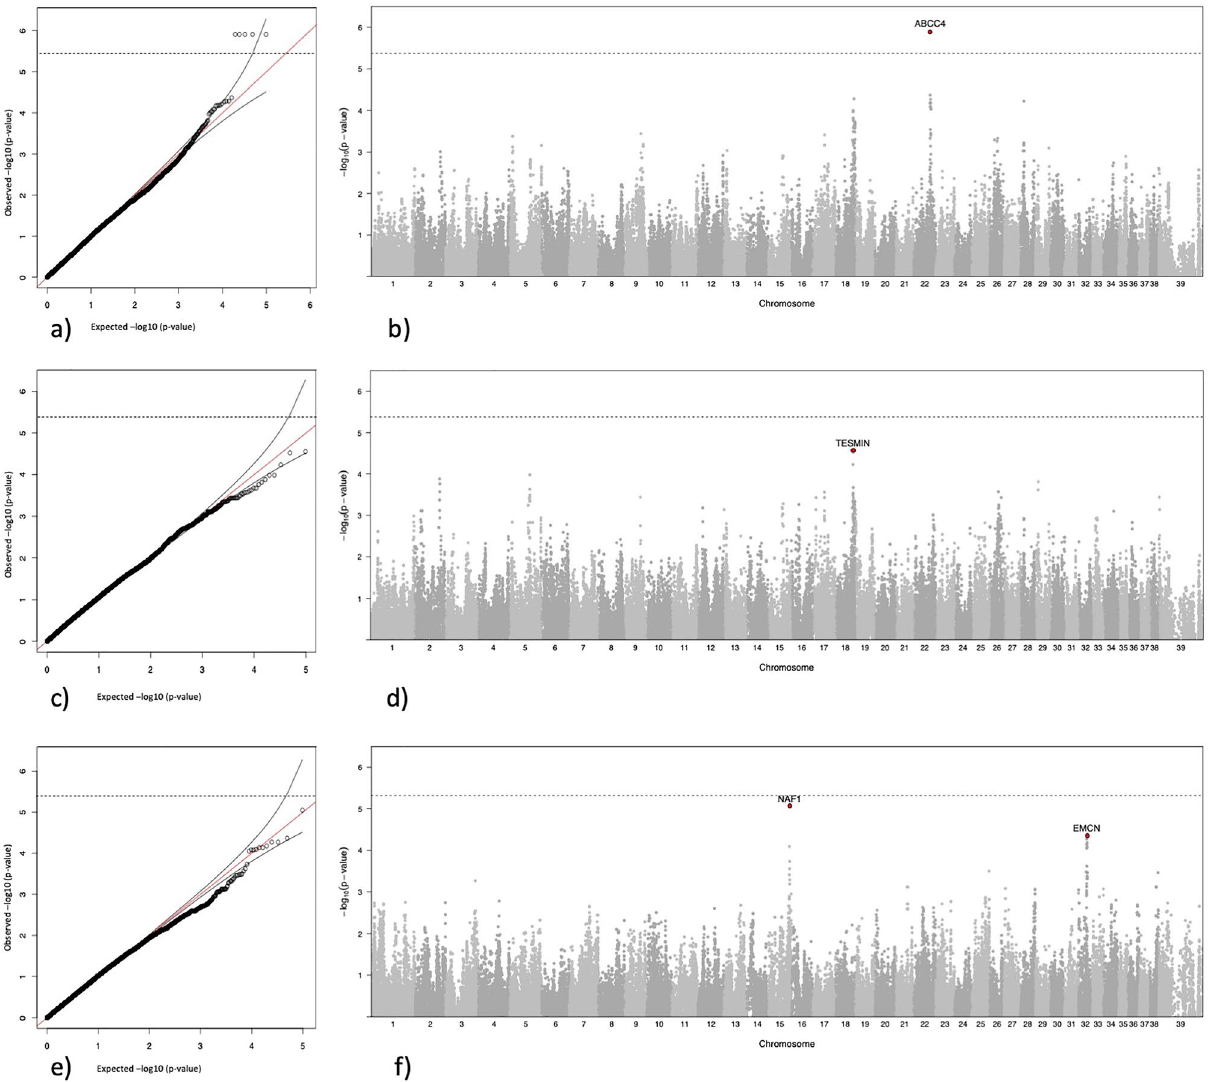
Figure 1. GWAS of pyometra in golden retrievers. ( a ) QQ-plot ( λ = 0.99) and ( b ) Manhattan plot for GWAS of 98 cases and 96 controls identified a genome-wide significant signal on chromosome 22. Stippled line shows Bonferroni corrected significance threshold. ( c ) QQ-plot and ( d ) Manhattan plot of conditional GWAS using the genotype for one of the most associated SNPs (chr22: 45,875,420) on chromosome 22 as covariate, illustrating a slightly stronger association on chromosome 18, and the disappearance of the association on chromosome 28. ( e ) QQ-plot and ( f ) Manhattan plot for age of onset analysis showed two suggestive loci on chromosome 15 and